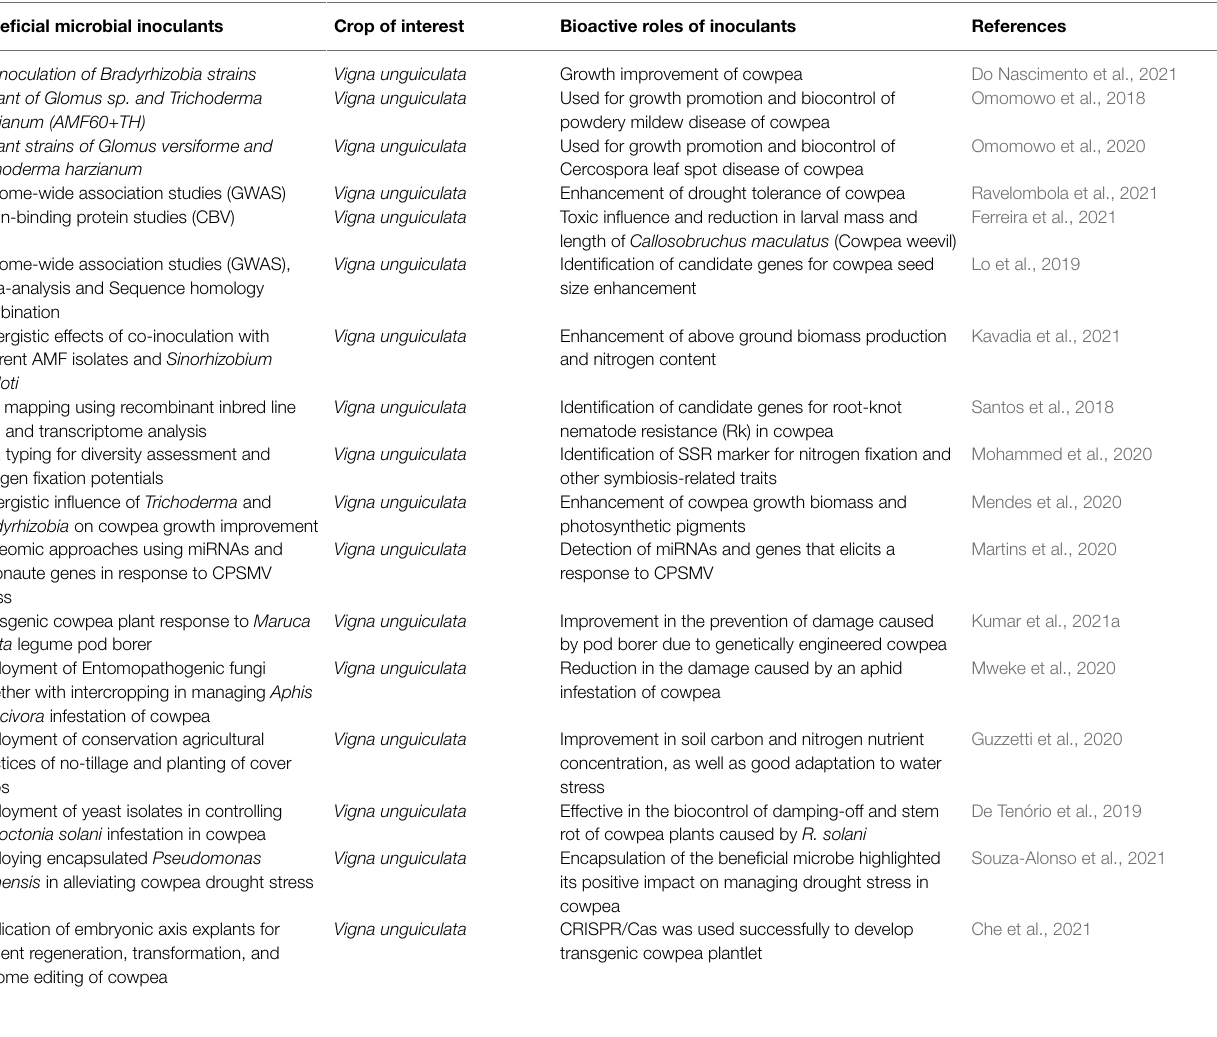
TABLE 3 | Sustainable deployment of bioinoculants and smart biotechnological techniques for the productivity enhancement of cowpea and some selected food crops. Beneficial microbial